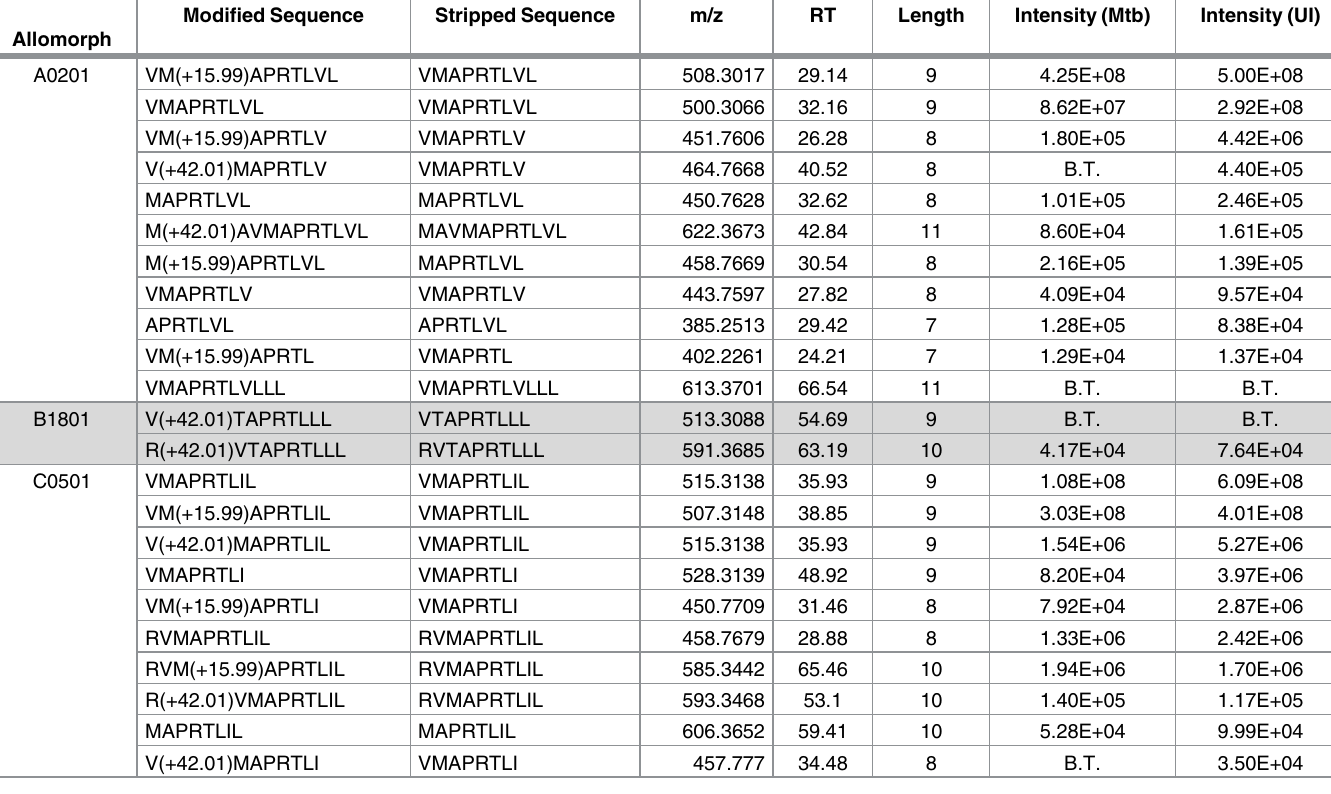
Table 1. Leader sequences associatedwith soluble HLA-E.